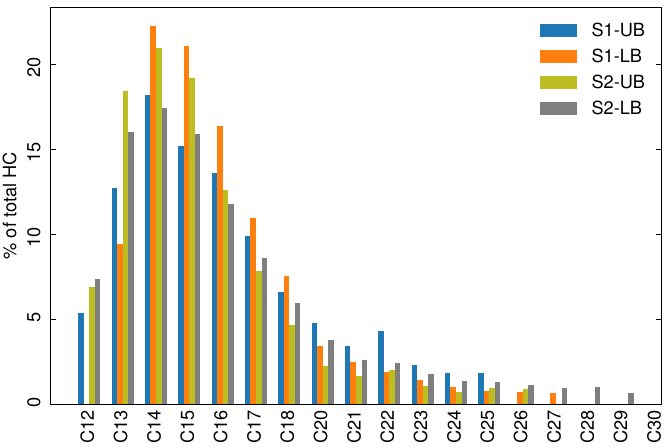
Figure 8. The GC analysis of the hydrocarbon extracts from untreated